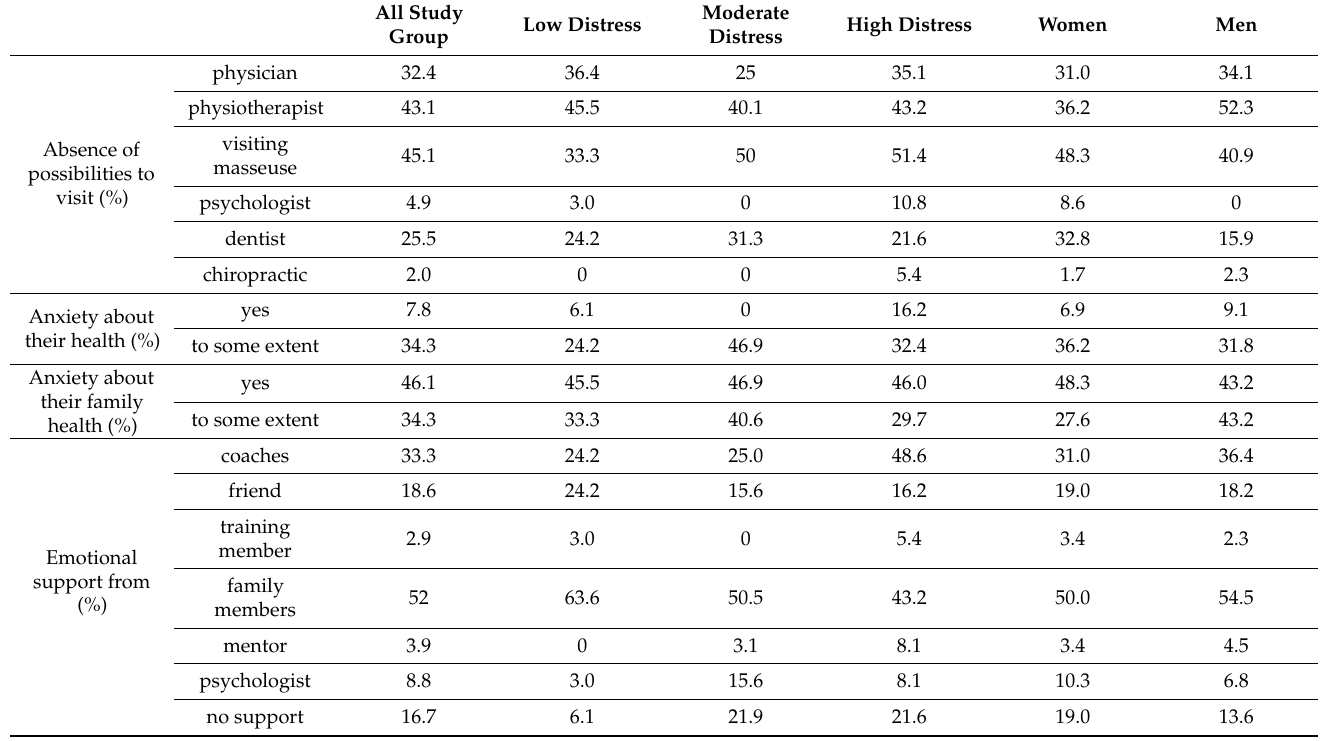
Table 2. COVID-19 related anxieties, lack of healthcare contacts, and sources of emotional support among athletes.